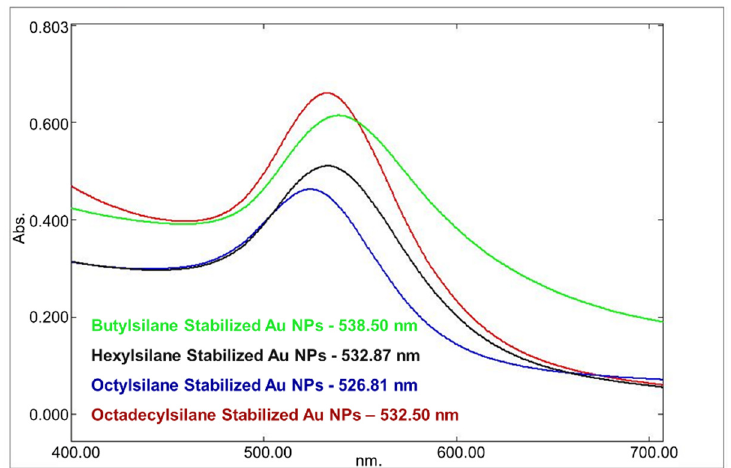
Figure 11. UV—Vis analysis of the nanoparticle—containing toluene layer of the phase transfer re- action with varying silane chain length.